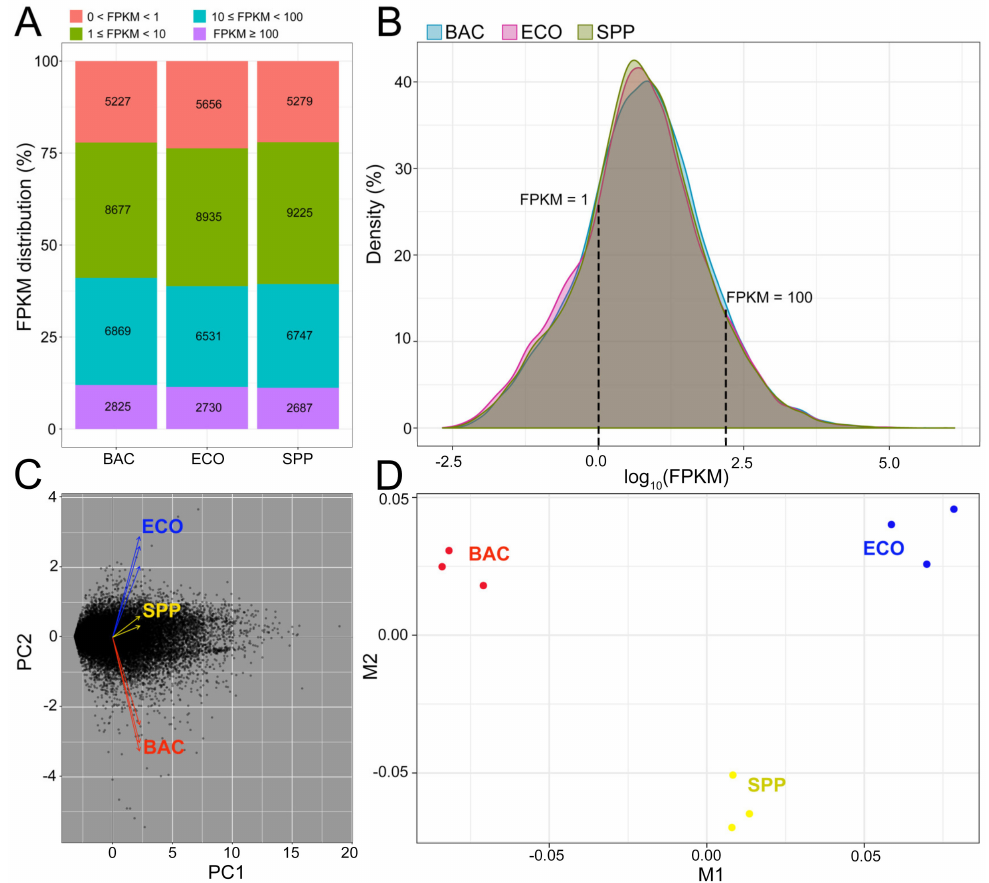
Figure 2. Overview of transcriptomes of T. thermophila cultured in the BAC, ECO, and SPP treatments, respectively. ( A ) Distribution of gene expression level in each treatment. ( B ) Density plot of the densities of the log 10 FPKM values across all genes, showing that fragments per kilobase of transcript per million fragments mapped (FPKM) ranges of the SPP (control) and two bacterial treatments were very similar, indicating no bias in the sequencing coverage among the treatments. ( C ) Principle component analysis and ( D ) multidimensional scaling based on all transcriptomic data, demonstrating the distinct gene expression pattern of the ciliate cultivated in the BAC (in red), compared to the SPP (in yellow) and the ECO treatment (in